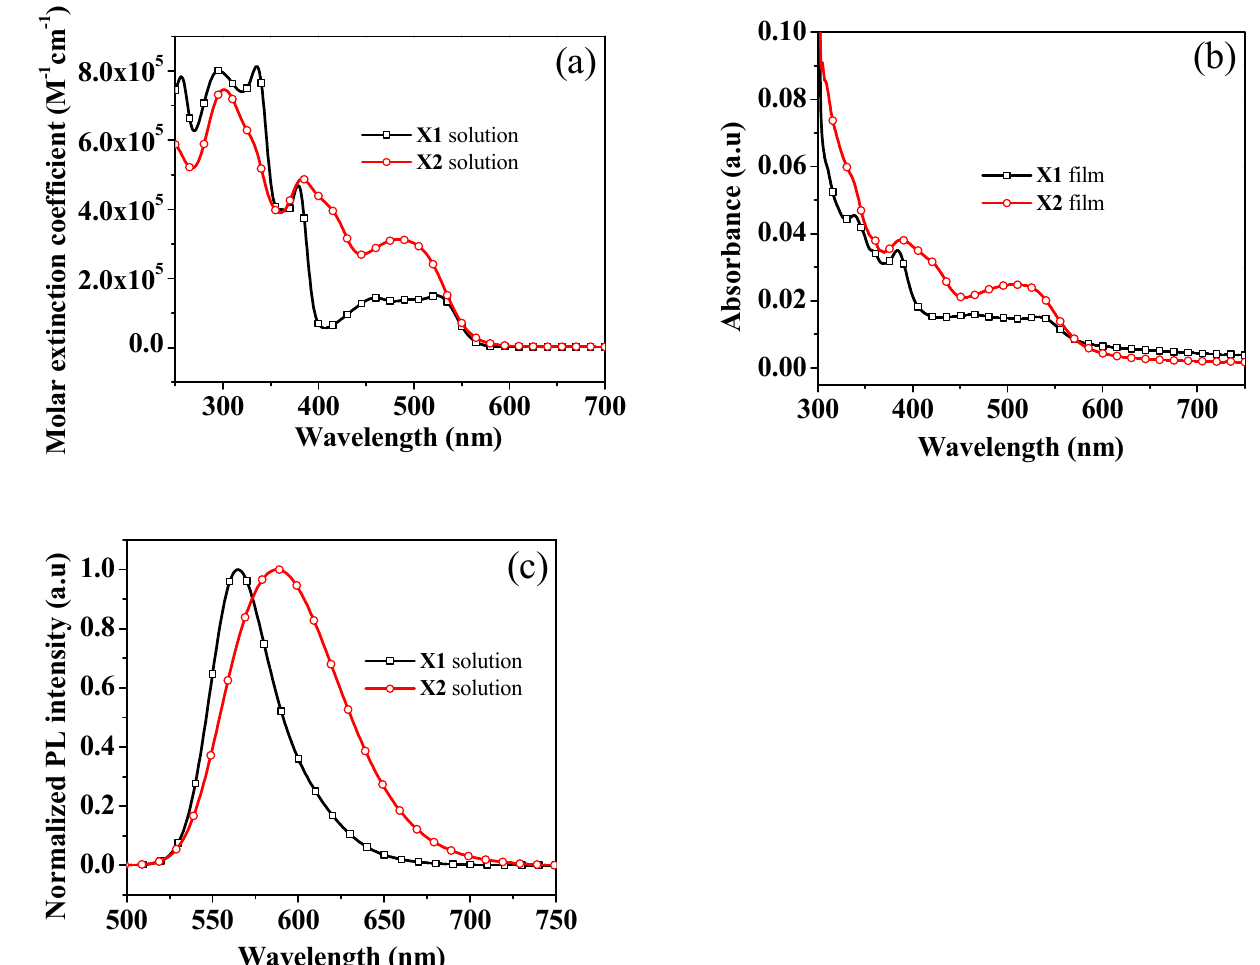
Figure 1. ( a ) UV–Vis absorption spectra of X1 , X2 in DCM solution; ( b ) Absorption spectra of X1 , X2 recorded in film state; ( c ) Emission spectra of X1 , X2 in DCM solution. Table 1. Optical, cyclic-voltammetry, thermal, hole-mobility properties of X1 , X2 , spiro-OMeTAD.